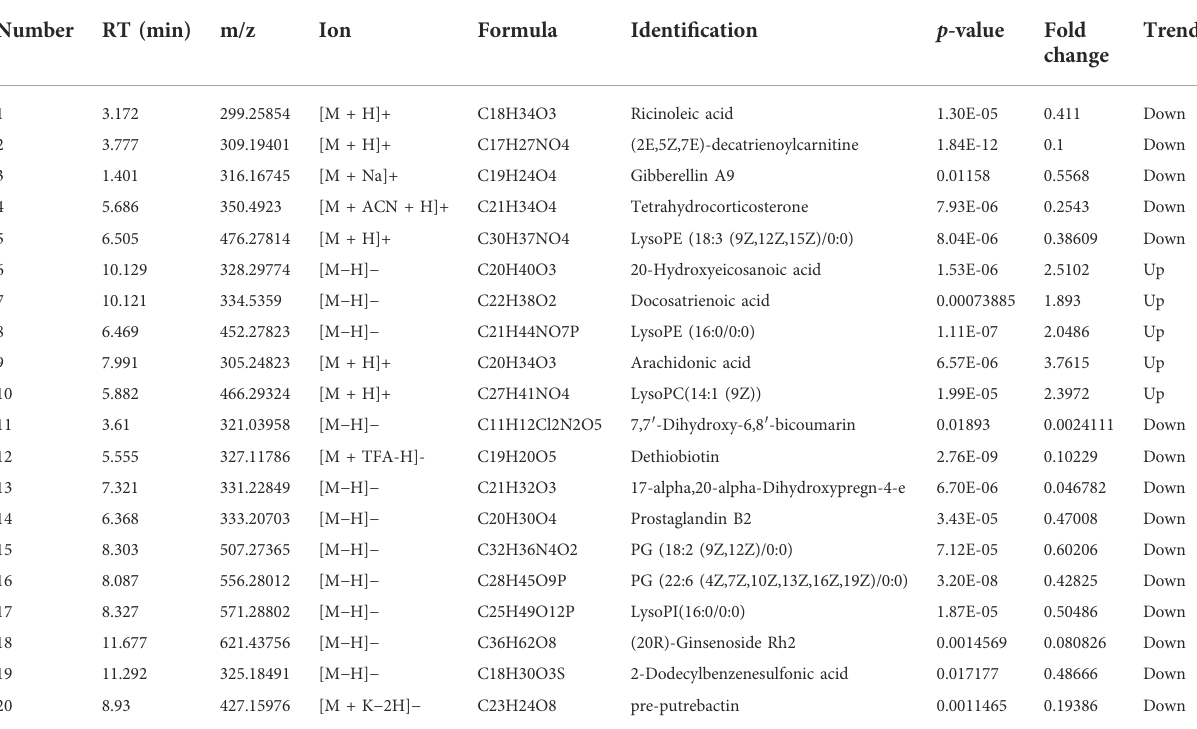
TABLE 2 Potential biomarkers of TZQ in the treatment of